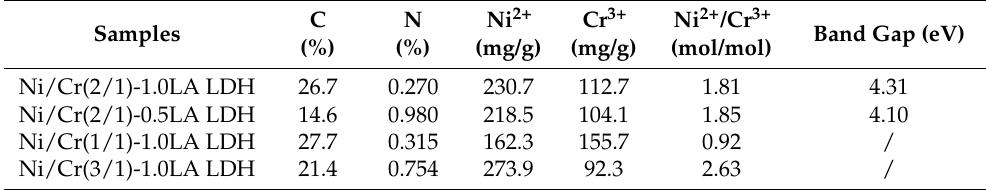
Table 1. Elemental analysis of Ni/Cr−LA LDHs.